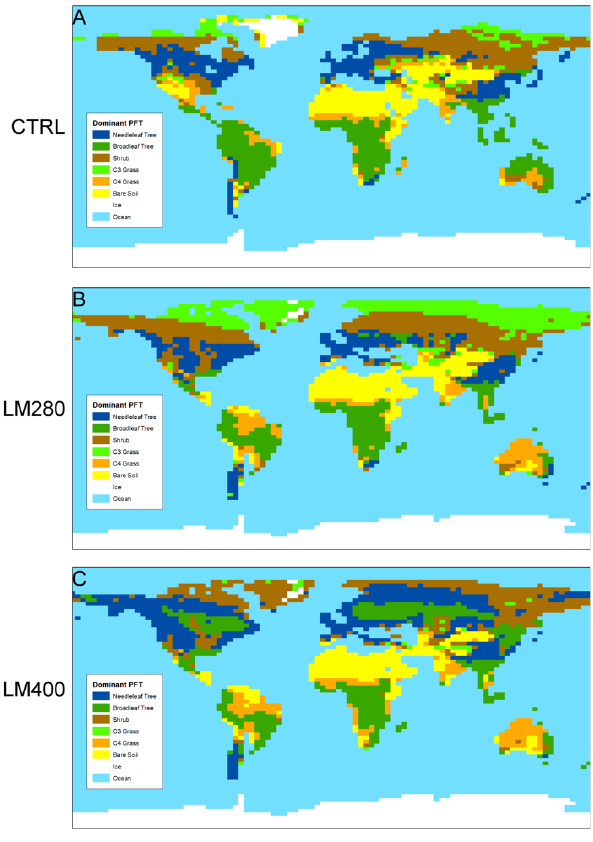
Fig. 6. Dominant PFTs of the late Miocene and preindustrial simu- lations, as predicted by the TRIFFID dynamic vegetation